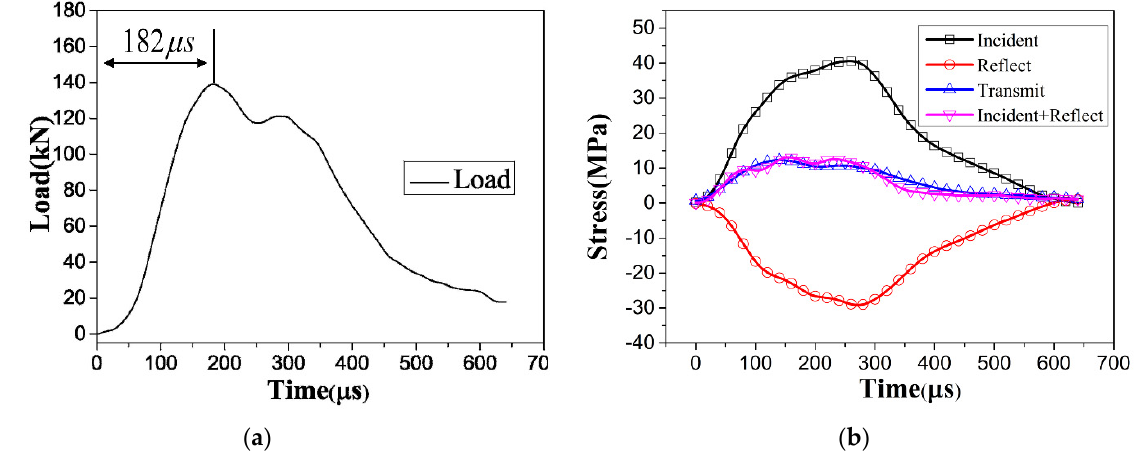
Figure 3. Load–time curve without a turning point. ( a ) Load–time curve, ( b ) equilibrium of stress.